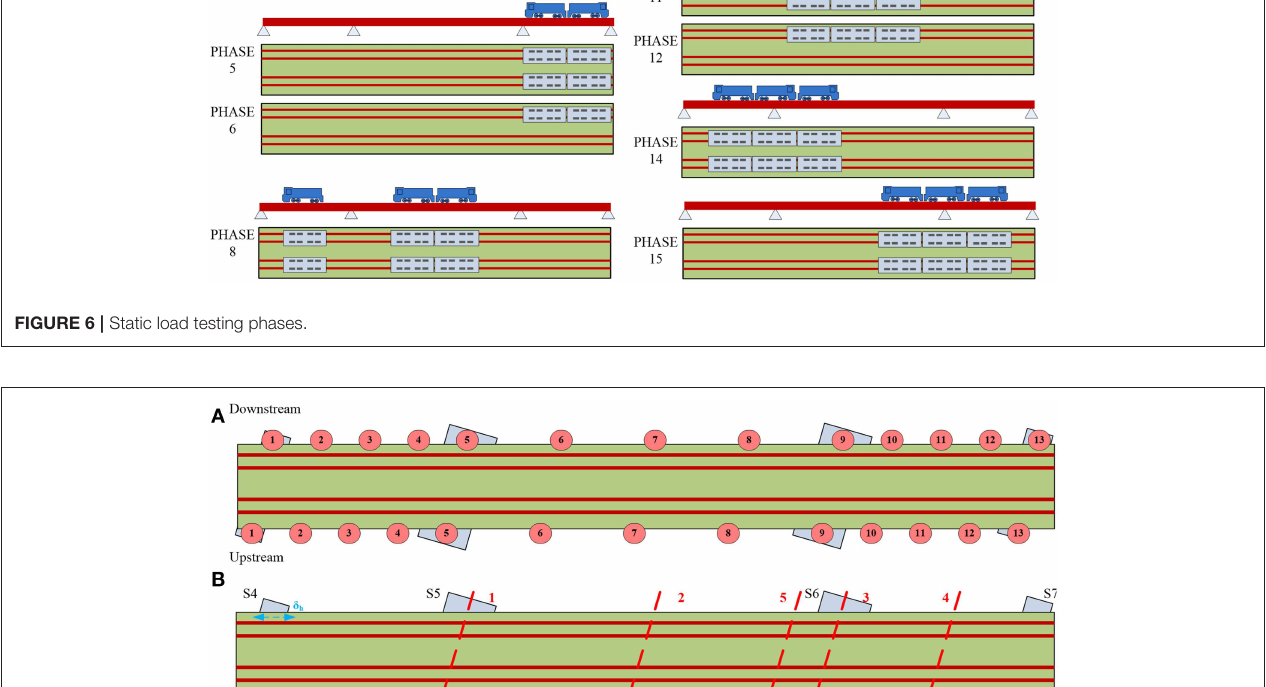
FIGURE 7 | Measuring points: (A) vertical displacement; (B)